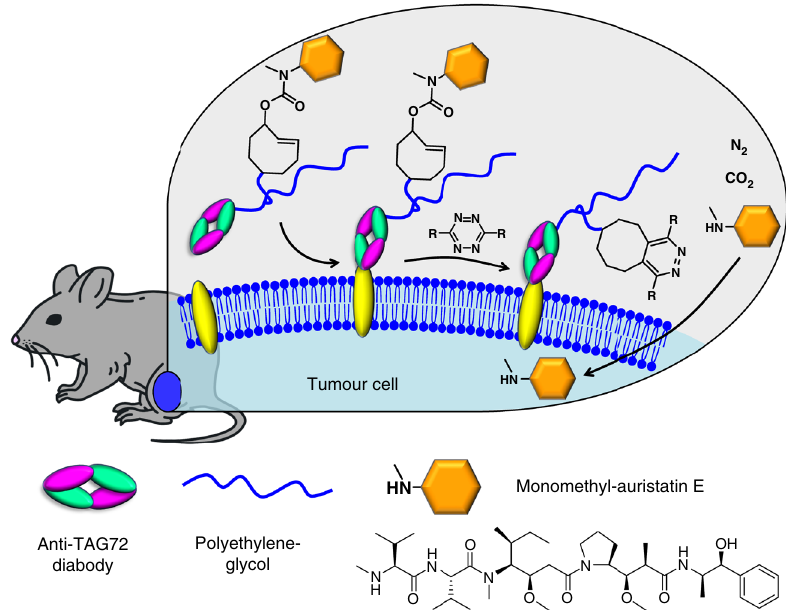
Fig. 1 Triggered drug release using “ click-to-release ” chemistry in vivo: on-tumour liberation of a cell permeable drug (monomethyl auristatin E, MMAE) from a trans -cyclooctene-linked ADC following systemic administration of a tetrazine